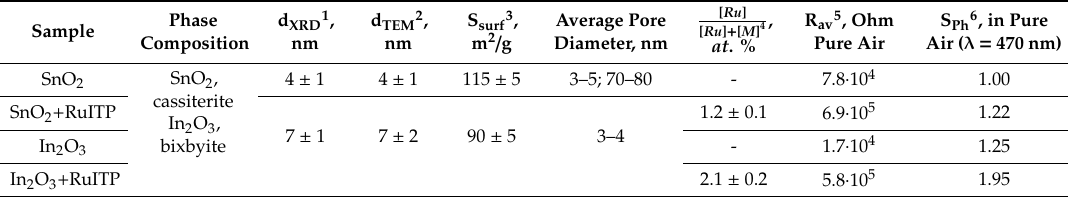
Table 1. Sensor characteristics of synthesized